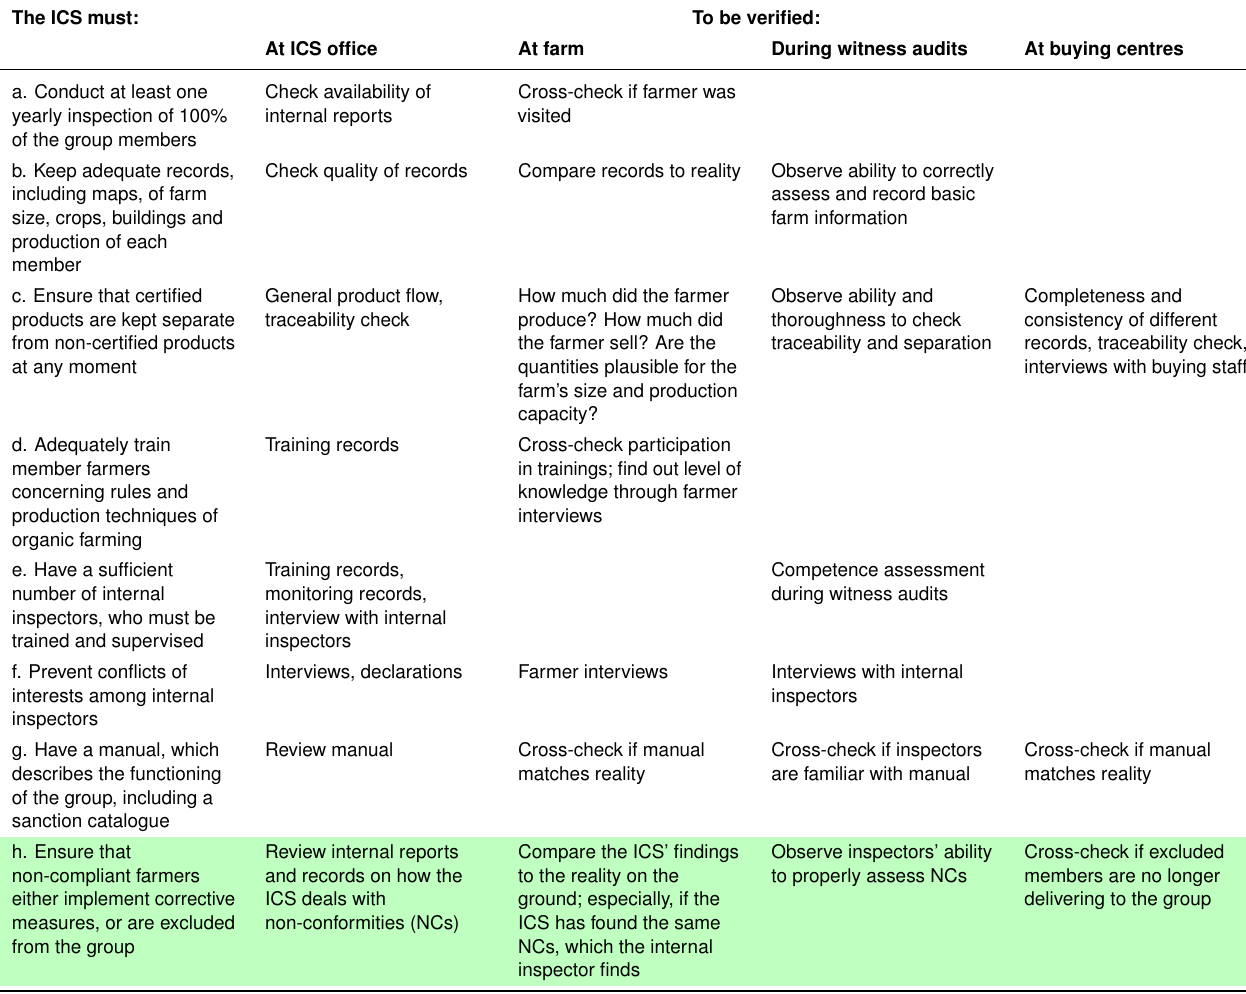
Table 1. Basic rules for the functioning of an